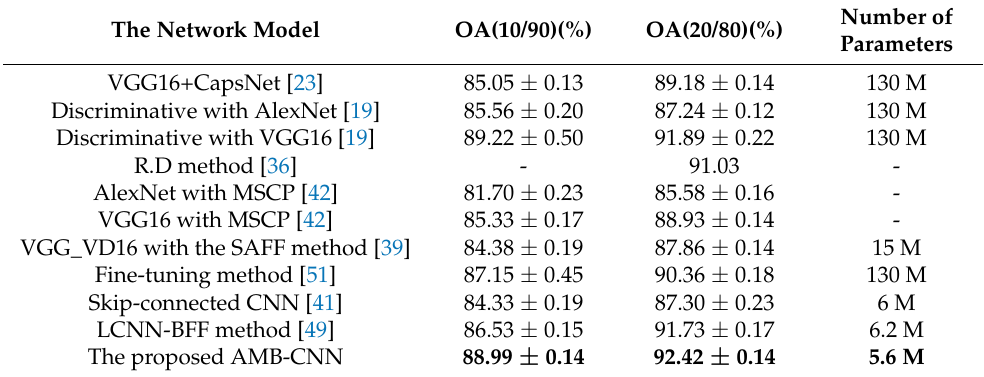
Table 5. Performance comparison of the proposed model with some state-of-the-art methods on the NWPU45 dataset.